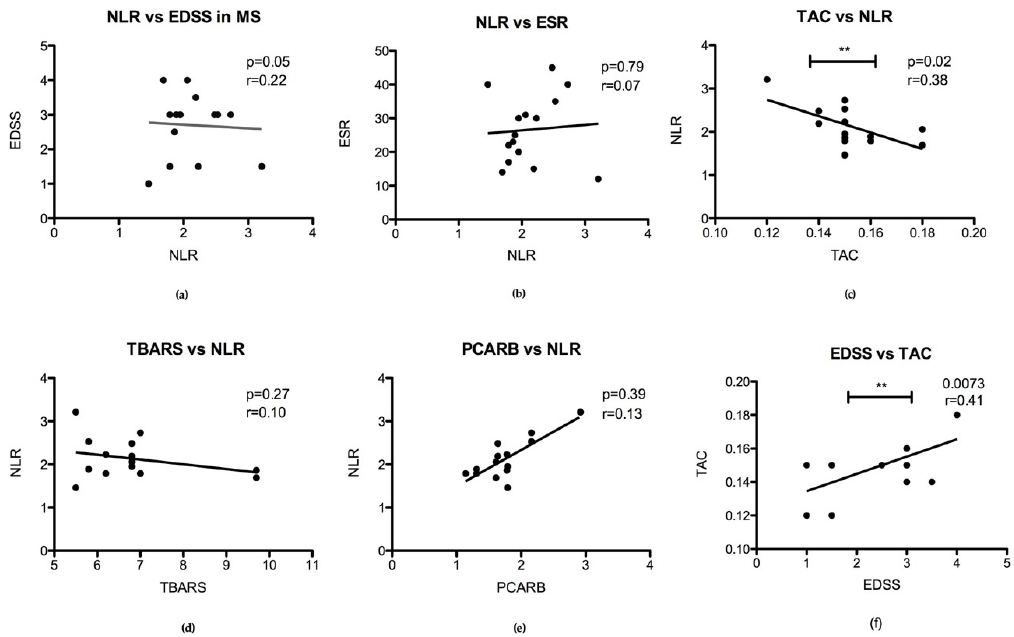
Figure 4. Correlation between inflammation marker NLR, oxidative stress status in plasma and disability stage (EDSS): ( a ) NLR correlation with EDSS ( p = 0.05); ( b ) correlation between NLR and ESR ( p = 0.79); ( c ) TAC and NLR correlation ( p = 0.02 **); ( d ) TBARS and NLR correlation ( p = 0.27); ( e ) PCARB with NLR correlation ( p = 0.39); ( f ) EDSS and TAC correlation in MS group 2 ( p = 0.0073 **).